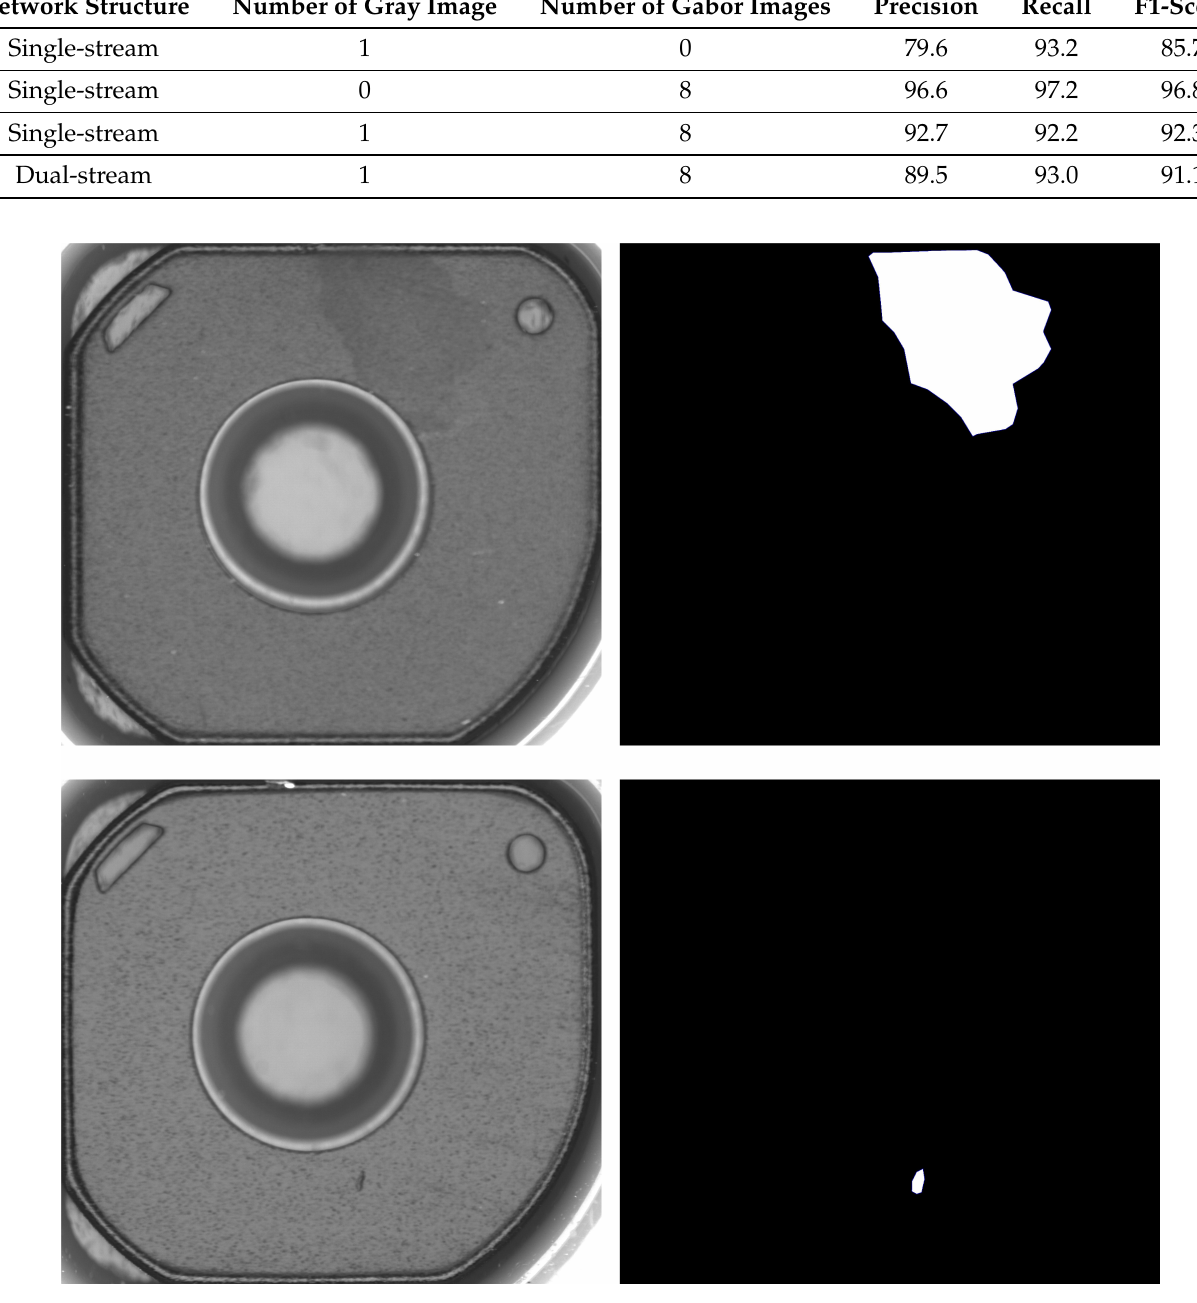
Figure 7. Compact Camera Module Dataset ( Left : image, Right : Stain Defect segmentation image). Table 7. Performance of defect detection method on compact camera module